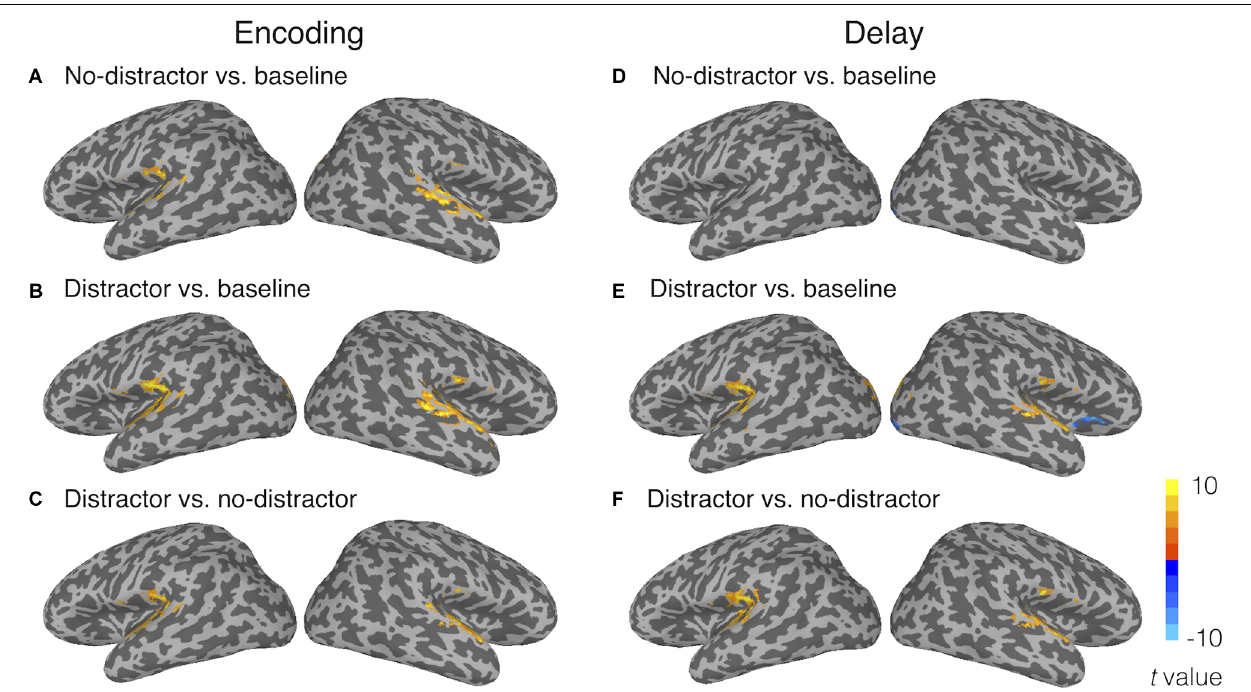
FIGURE 3 | Univariate activation results during (A–C) the encoding period and (D–F) the delay period. Panels (A) and (D) show the activated regions for the no-distractor condition relative to the fixation baseline; (B) and (E) reveal the activated regions for the distractor condition relative to the fixation baseline; (C) and (F) show the contrasts of distractor vs. no-distractor conditions. The activation threshold was set at voxel-wise p < 0.001 and corrected at cluster-wise α < 0.05 (cluster size > 29